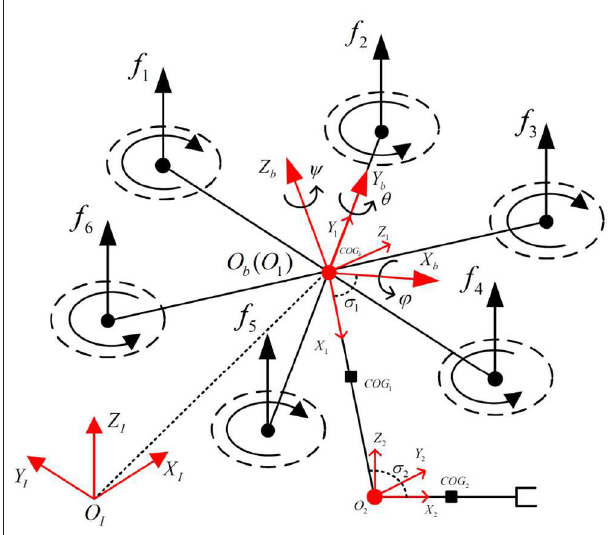
FIGURE 1 | Illustration of the hexacopter and robotic arm system with related coordinate reference